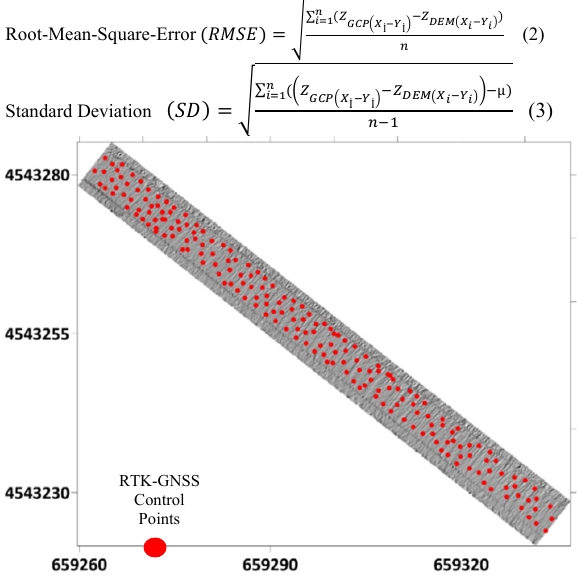
Figure 4. Example of shaded relief map of DEM where red dots shows distribution of RTK-GNSS ground control